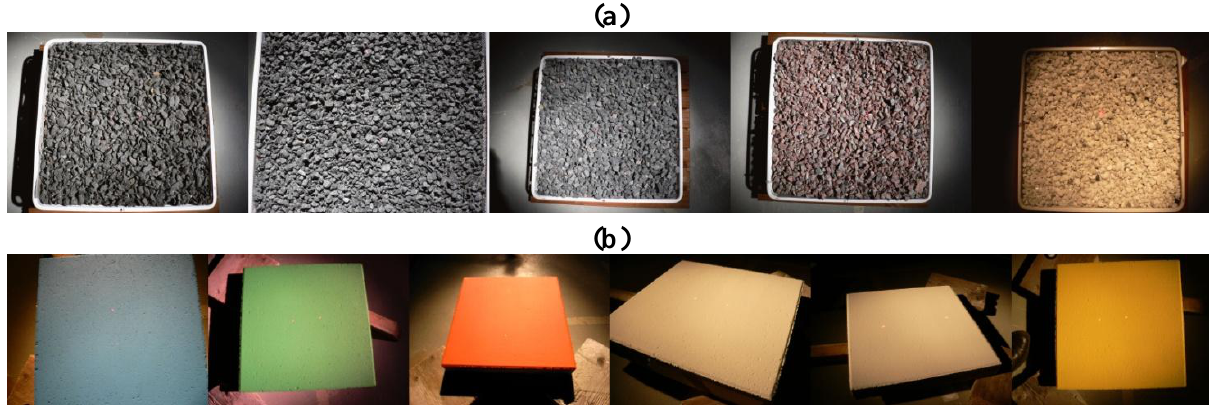
Figure 4. Examples of various target types. (a) Gravel targets of size 50 cm × 50 cm. From left: B1, B2a, G2, R1, W2. (b) Painted concrete targets of size 40 cm × 40 cm. From left: blue, green, red, white, grey and yellow. Colors and brightness are not calibrated or adjusted to the same